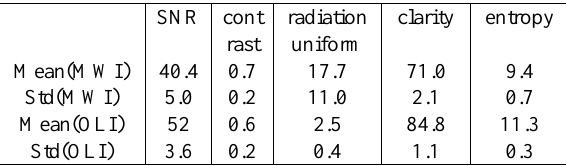
Table 6. Data quality evaluation results comparison between MWI and OLI in image of Qinghai Lake In table 5 and table 6, the Mean and Std were the average value and the standard deviation of the similar bands. For MWI, the similar bands are band2, band3, band5, band7, band11 and band16. For OLI, the similar bands are form band1 to band6. As shown in table 5 and table 6, the image contrast of MWI data is larger than that of OLI in both Qinghai Lake and Dunhuang Desert. In other indexes, such as SNR,